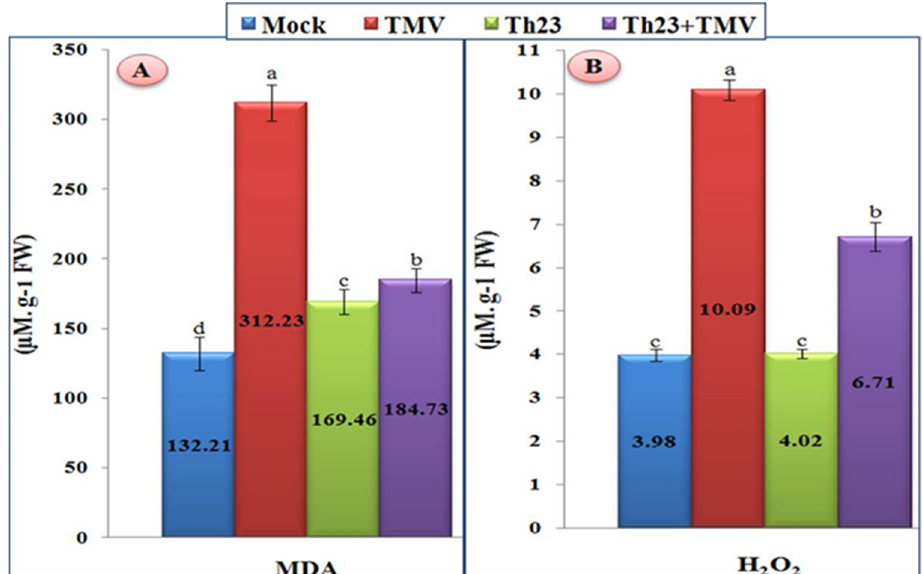
Figure 3. ( A ) Malondialdehyde content (MDA) and ( B ) hydrogen peroxide accumulation levels as affected by various treatments including untreated plants (mock), TMV-treated plants (TMV), Trichoderma hamatum strain Th23 application (Th23), and T. hamatum strain Th23 application 48 h before TMV inoculation (Th23 + TMV). The mean values in each of the columns that begin with the same letter are not statistically different ( p ≤ 0.05).